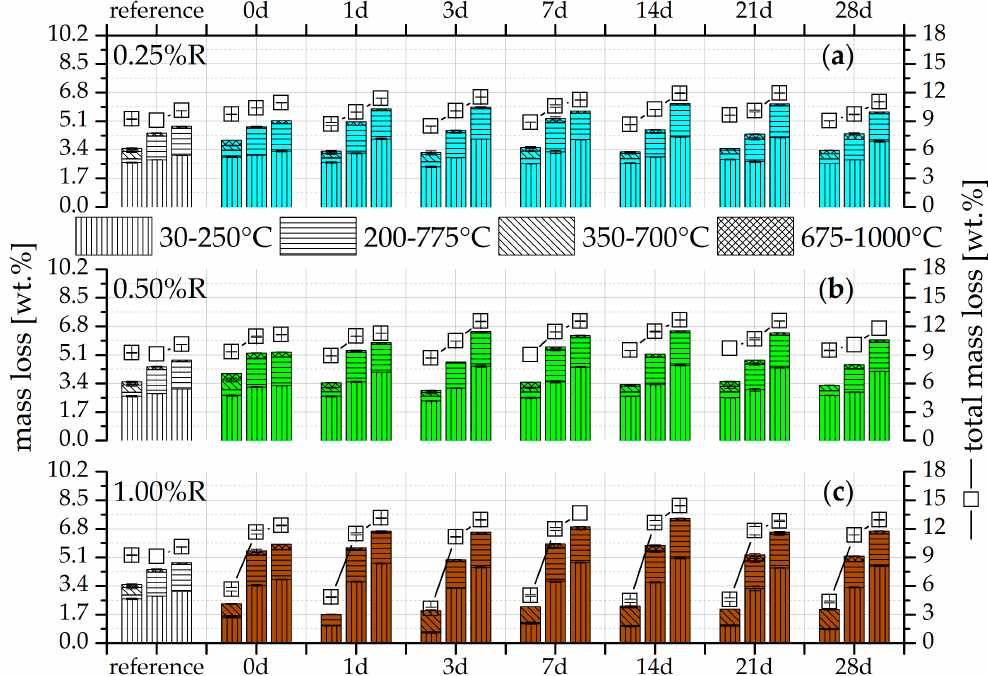
Figure 3. Mass loss by TG of Ac1 after seven, 28 and 90 days (from left to right, per test) after the beginning of the hydration of the reference of Ac1 (without retarder) and the reactivated mixtures with NaOH after seven different periods of retardation with ( a ) 0.25%; ( b ) 0.50%; and ( c ) 1.00%R.